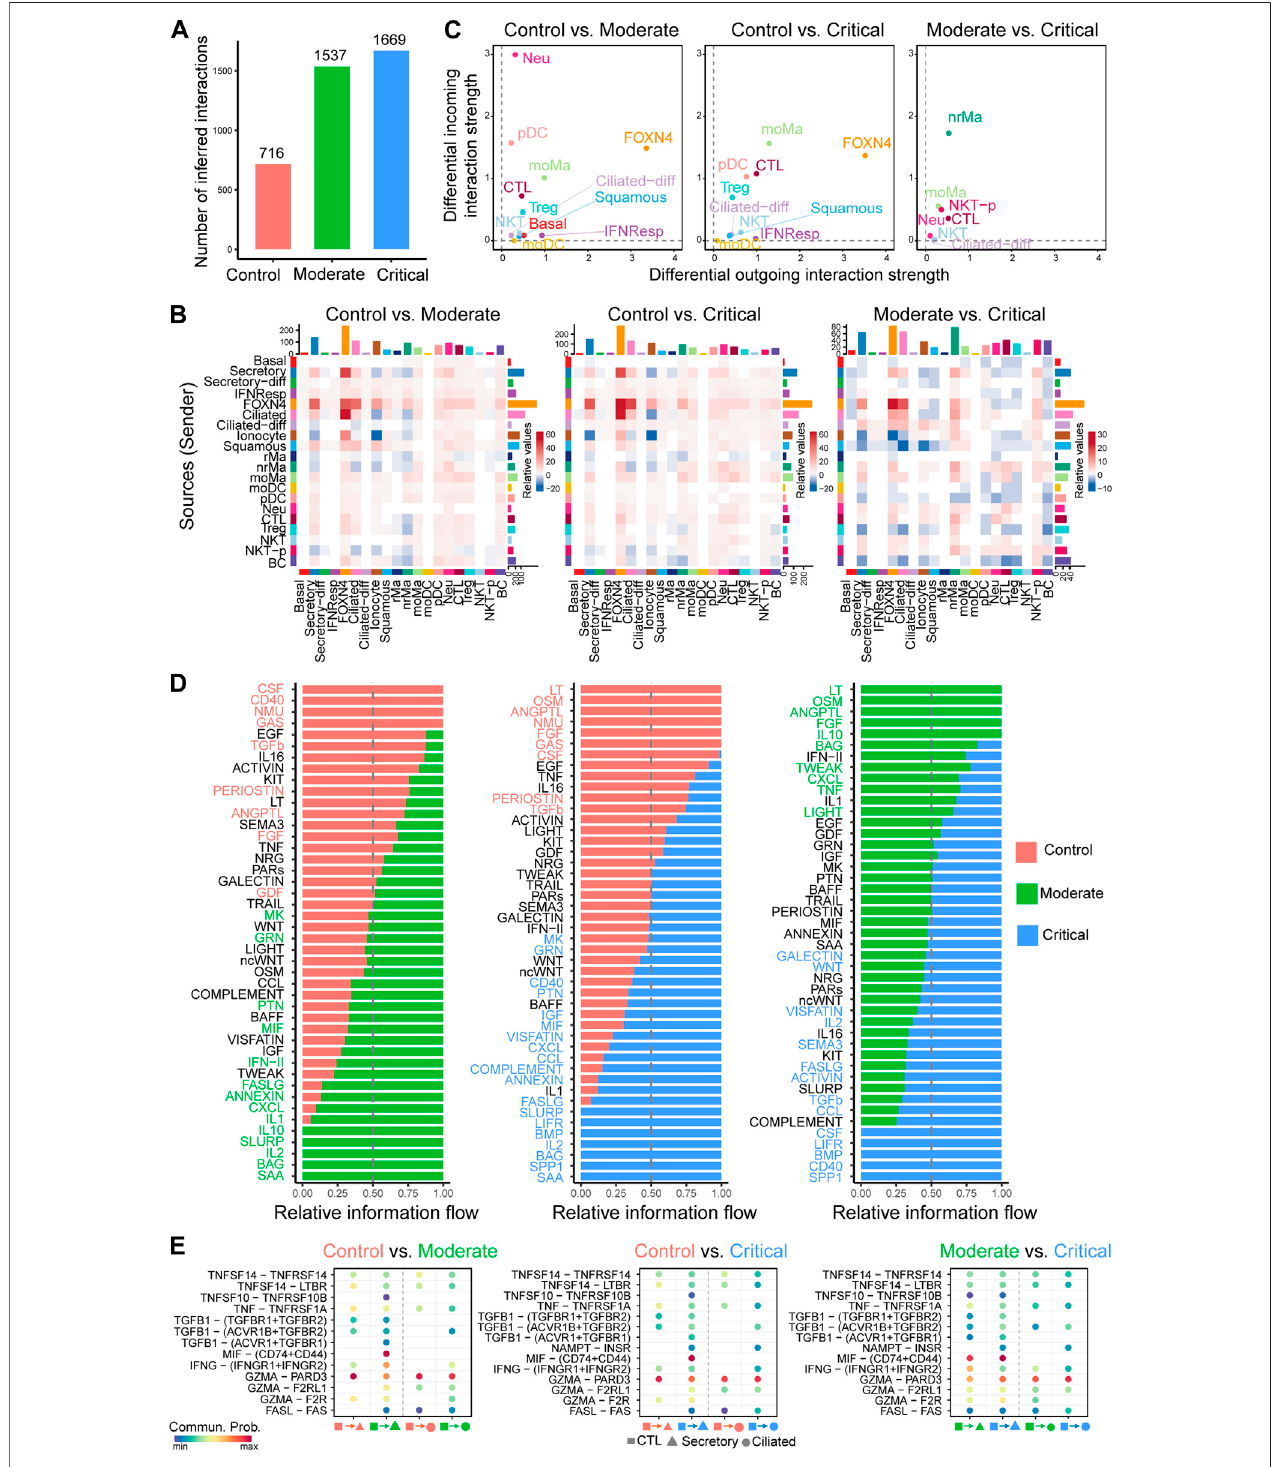
FIGURE 4 | Comparison analysis of cell – cell communication identi fi es major signaling changes in patients with COVID-19 across control, moderate, and critical cases. (A) Comparison of the number of interactions among different cell populations. (B) Differential number of interactions in the cell – cell communication network between control, moderate, and critical in greater details. (C) Signaling changes of the major cell groups that send or receive signals. Positive values in the differential outgoing (or incoming) interaction strength suggest the increased likelihood being sender (or receiver) in the second dataset compared to the fi rst dataset. (D) The comparisonofthesignalingpathwaybasedontherelativeinformation fl owbetweenpairwisedatasets. (E) Identifyingalteredligand – receptorpairsfromCTLtosecretory and ciliated cells by comparing their communication probabilities between control, moderate, and critical.